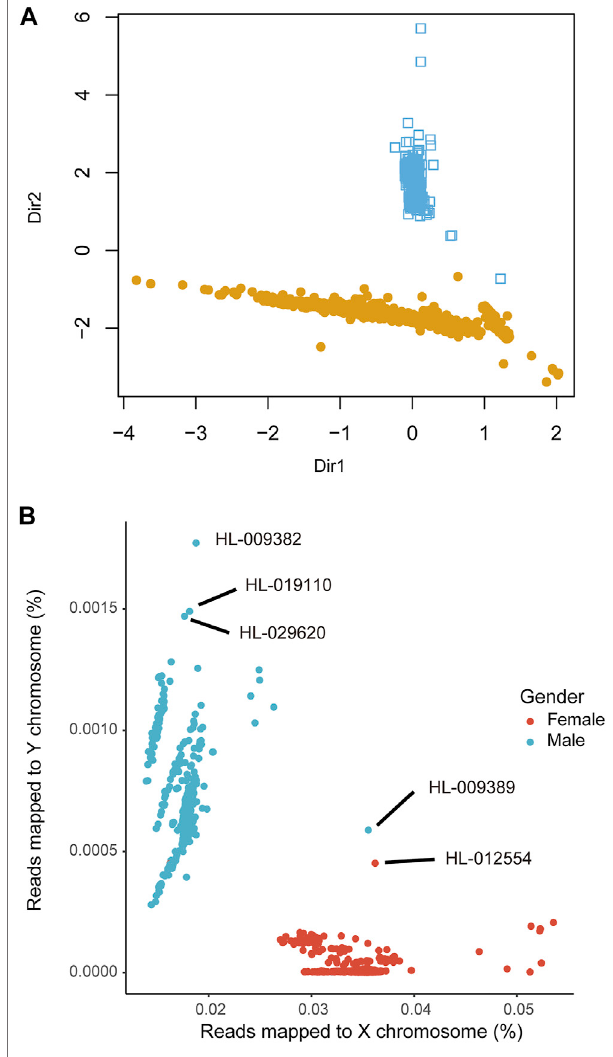
FIGURE4| Theprediction accuracyofseGMMininferringthegender of samples from the in-house WES dataset. (A) Sample clustering results of seGMM. The colors represent different sample clusters. Dir1 and Dir2 represent eigenvectors that specify the discriminant subspace generated from the features included in the GMM model. (B) Scatter plot shows the reads mapped to the X and Y chromosomes. As shown,